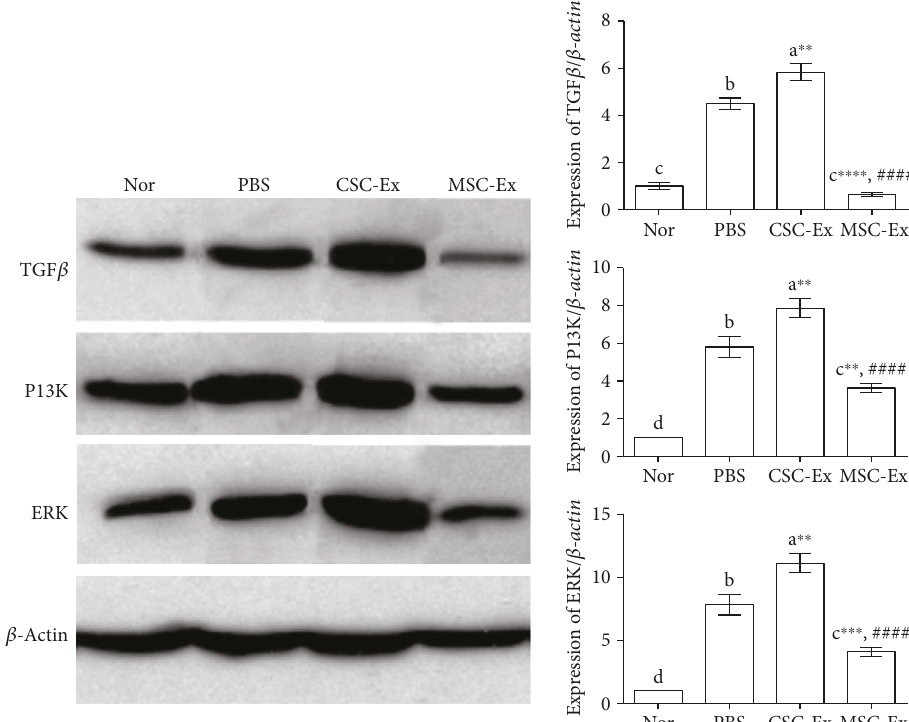
Figure 9: E ff ect of exosomes derived from CSCs and MSCs on the expression of TGFb, P13K, and ERK proteins in livers of DEN-induced HCC rats using Western blotting. β -Actin was used as a control for internal protein loading. Band intensity revealed relative changes in protein expression using the normal group as a control. Values were expressed as mean ± SEM , n = 9 , from two separate experiments. Di ff erent letters on columns mean signi fi cant di ff erence. ∗∗ P < 0 01 , ∗∗∗ P < 0 001 , and ∗∗∗∗ P < 0 0001 versus PBS group; #### P < 0 0001 versus CSC